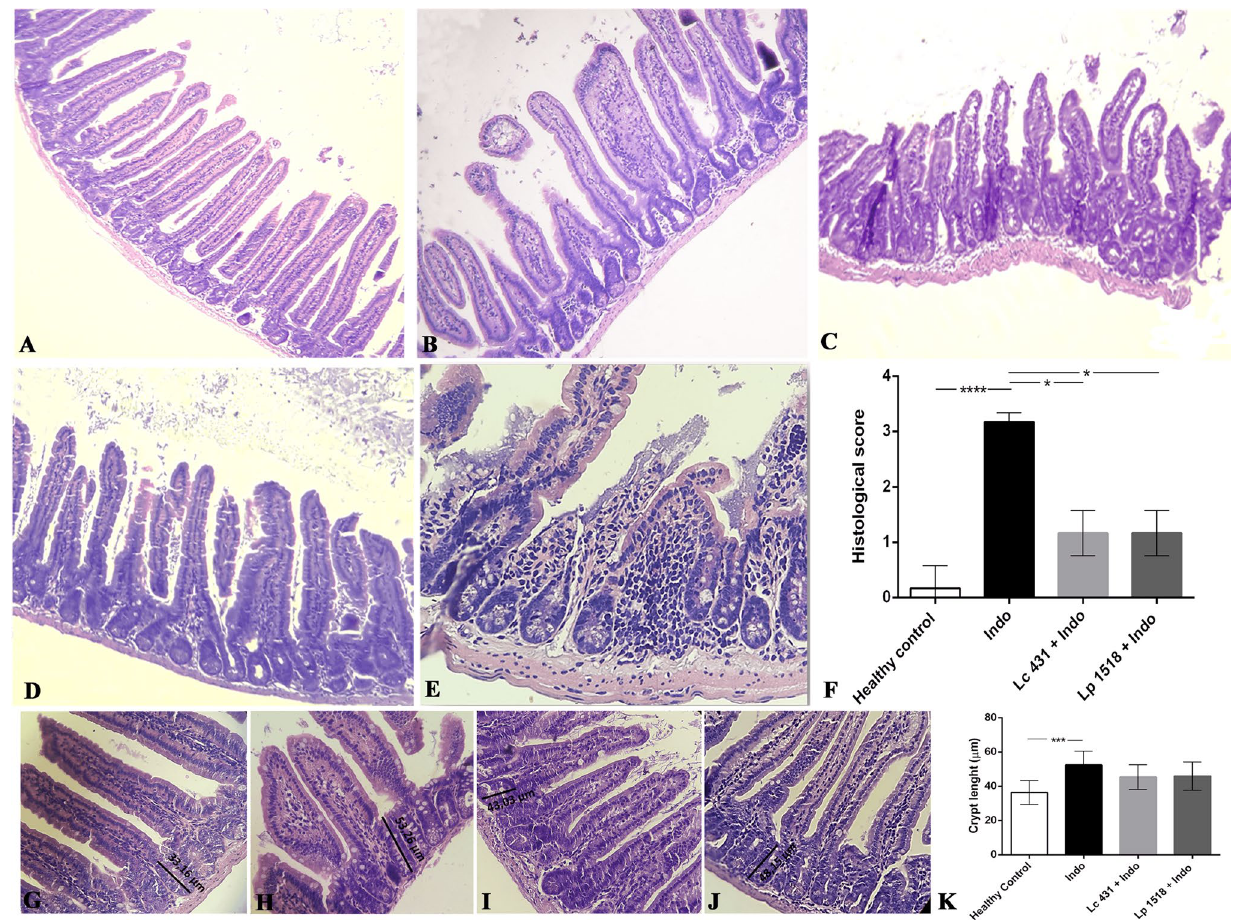
Figure 3. Hematoxylin and eosin staining of small intestine tissue section. Balb/c mice supplemented with L. casei CRL 431 (Lc 431), L. paracasei CNCM I-1518 (Lp 1518), or water, for 7 and 5 days, received indomethacin injections on the last two days. On day 8 mice were euthanized and samples of the small intestine were taken for histological analysis. Representative micrographs of: ( A , G ) Healthy control; ( B , E , H ) mice on a conventional diet treated with indomethacin; ( C , I ) Lc 431 + Indo; and ( D , J ) Lp 1518 + Indo. ( D ) Inflammatory cells infiltrated in indomethacin-treated mice on a conventional diet. ( F ) Inflammation was qualitatively evaluated according to the number and spread of inflammatory foci from 0 to 4: 0, no leukocytic infiltration; 1, low level of leukocytic infiltration; 2, moderate level of leukocytic infiltration; 3, high level of leukocytic infiltration; and 4, transmural infiltration 54 . * p < 0.05 *** p < 0.001. ( K ) Length of Lieberkühn crypt in the small intestine of experimental mice. Results (mean ± S.E.M.) are representative of three independent experiments. The line at the top of the bars indicates comparison between the two groups. *** p < 0.01. Magnification: (A-D) 100X, (E, G-J) 400X. Lines in panels G, H, I and J mean: 33.16, 53.26, 43.03 and 48.15 µm,